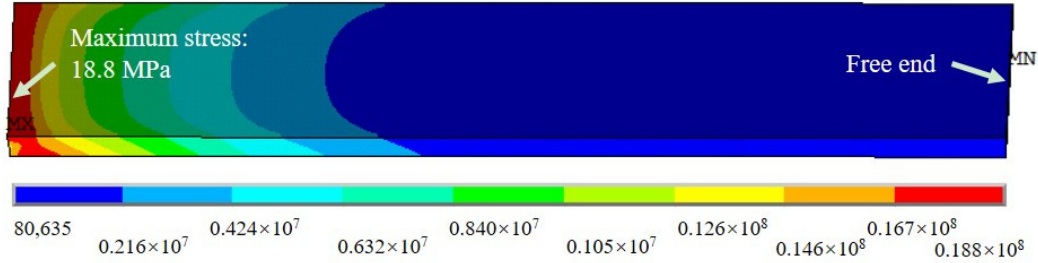
Figure 4. The von Mises stresses of the adhesive layer for the tensile joint.